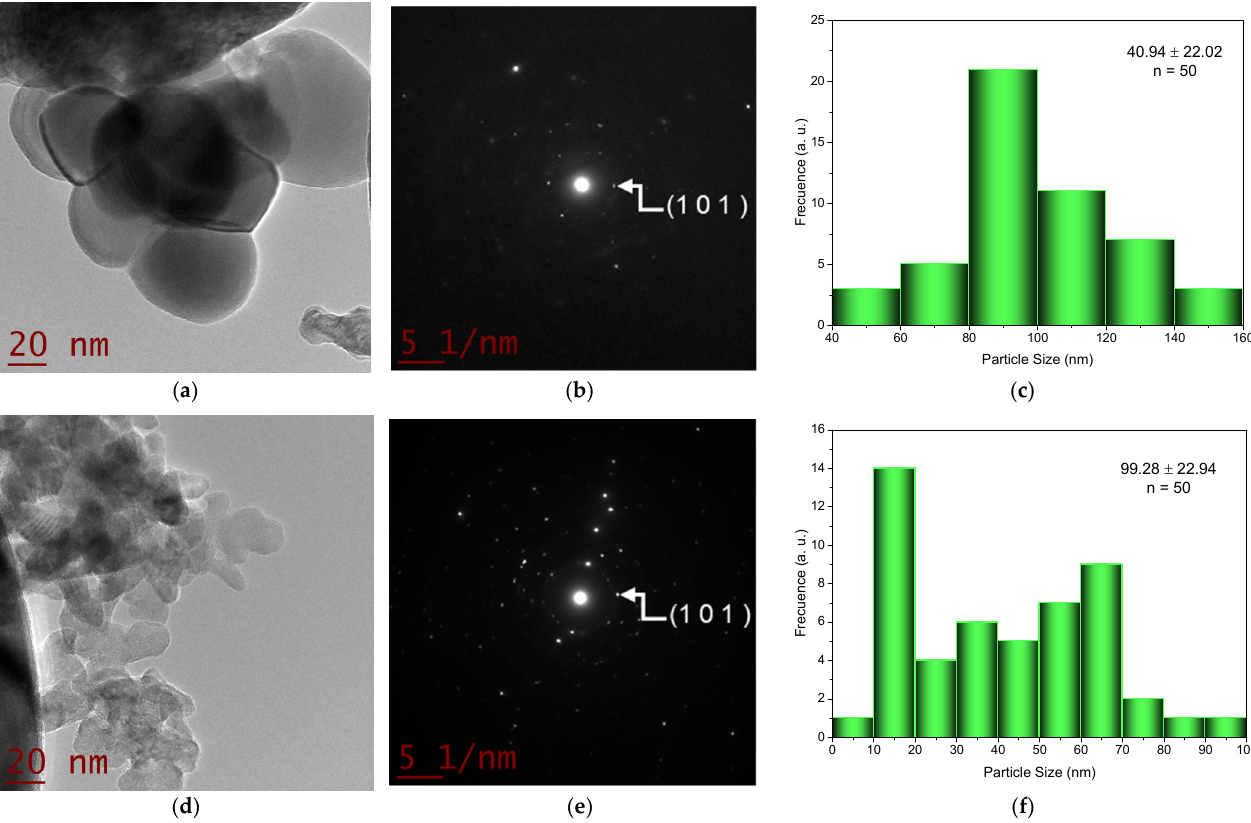
Figure 2. Micrographics of TEM of ZnO N ( a ) and ZnO A ( d ); SAED of ZnO N ( b ) and ZnO A ( e ); and particle size distribution of ZnO N ( c ) and ZnO A ( f ).